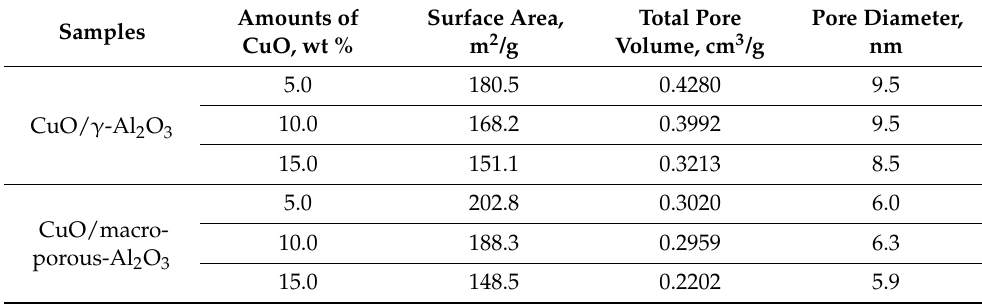
Figure 7. Adsorption (blue) and desorption (red) isotherm of Cu-based desulfurization sorbents by the N 2 -adsorption method: ( a ) 5 wt % CuO/ γ -Al 2 O 3 ; ( b ) 10 wt % CuO/ γ -Al 2 O 3 ; ( c ) 15 wt % CuO/ γ -Al 2 O 3 ; ( d ) 5 wt % CuO/macro-porous Al 2 O 3 ; ( e ) 10 wt % CuO/macro-porous Al 2 O 3 ; and ( f ) 15 wt % CuO/macro-porous Al 2 O 3 . Table 1. Surface and pore properties of the Cu-based desulfurization sorbents by the N 2 -adsorption